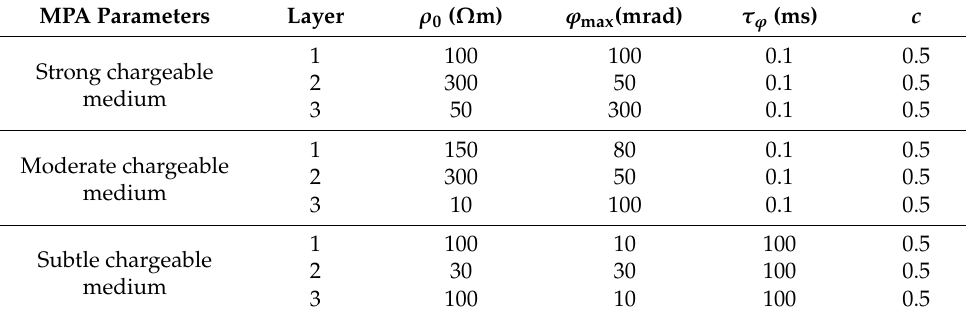
Table 1. The parameters of the synthetic three-layered chargeable